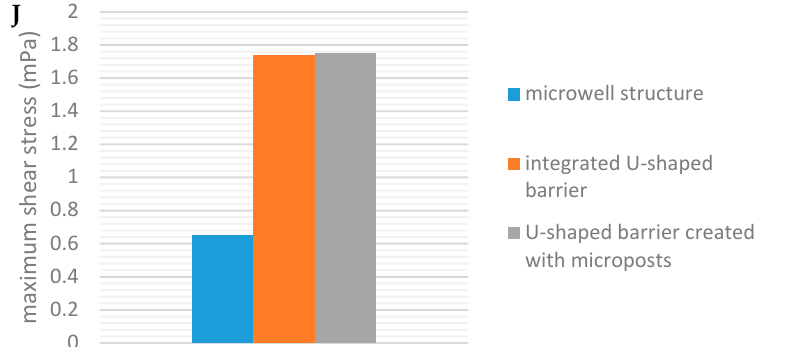
Figure 10. Comparison of the different traps, i.e., ( A ) microwell structure; ( B ) integrated U-shaped barrier and ( C ) U-shaped barrier created with microposts, on the oxygen ( D – F ) and glucose ( G – I ) concentration distribution inside the spheroid and maximum shear stress on its surface ( J , E ) the proliferating, quiescent and necrotic zones due to oxygen deficiency in the middle x – z plane of the spheroid in the microwell, ( F , G ) oxygen concentration distribution in the middle x – z plane of the spheroid in the integrated U-shaped barrier and U-shaped barrier created with microposts, respectively, ( H – J ) the proliferating, quiescent and necrotic zones due to glucose deficiency in the middle x – z plane of the spheroid in the microwell, U-shaped barrier and U-shaped barrier created with microposts, respectively (the simulations are done under D = 400 µ m, Q = 5 µ L/min, c 0, O 0.2 mM and c 0, glucose = 0.7 mM).